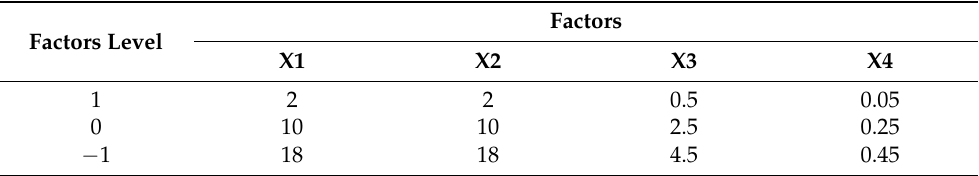
Table 2. Levels of factors (g/L) in a full factorial experiment 2 4